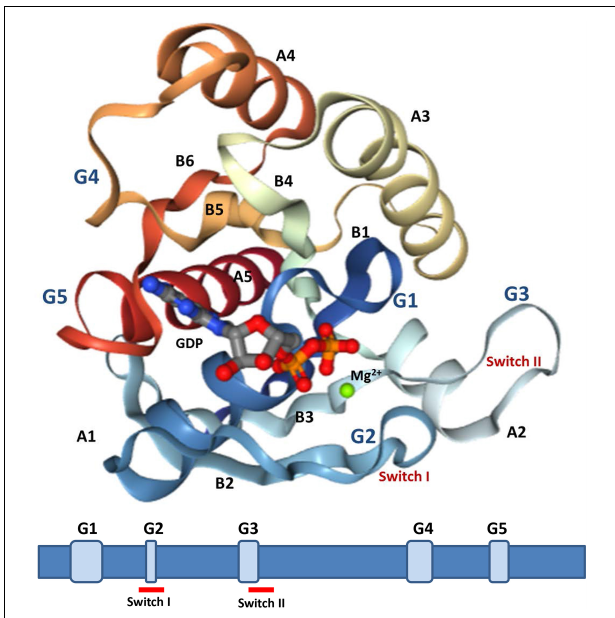
FIGURE 3 | Structures analysis of Ras. The crystal structures of Ras GDP Mg 2 + complex (PDB 4q21) is showed (upper). This structure contains five α -helices (A1–A5), six β -strands (B1–B6), and five polypeptide loops (G1–G5) and the position relationship among various parts is displayed